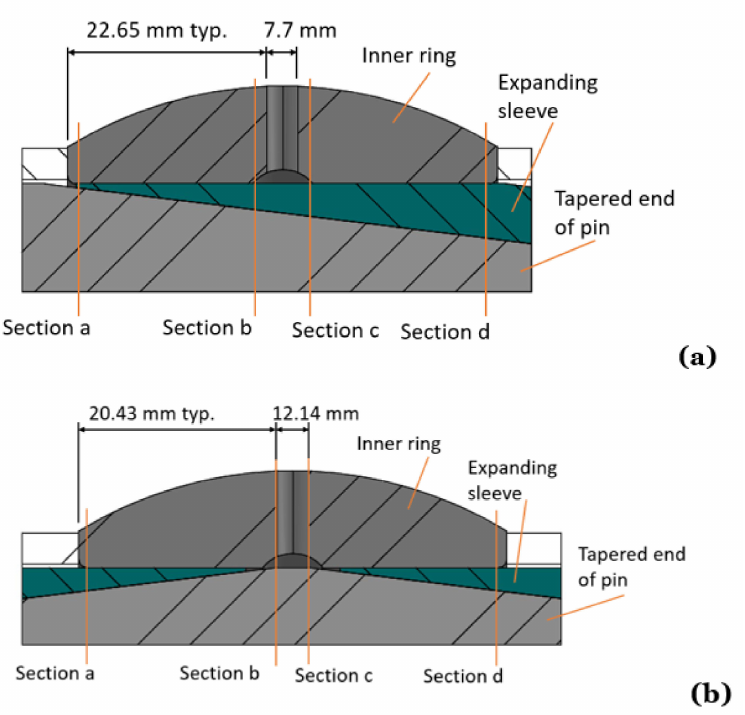
Figure 6. Ring, sleeve, and pin contact area: ( a ) full contact on single sleeve and ( b ) reduced contact at center on double